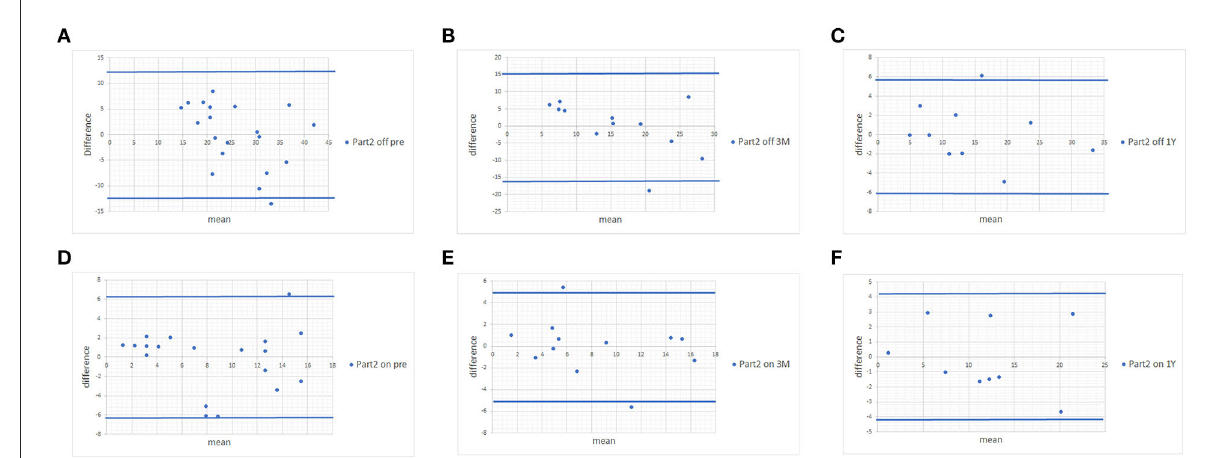
FIGURE1 Bland-Altman plots of MDS-UPDRS Part II scores and scores estimated from the UPDRS. (A) Pre-operative MDS-UPDRS during the off phase. (B) Post-operative MDS-UPDRS 3 months after surgery during the off phase. (C) Post-operative MDS-UPDRS 1 year after surgery during the off phase. (D) Pre-operative MDS-UPDRS during the on phase. (E) Post-operative MDS-UPDRS 3 months after surgery during the on phase. (F) Post-operative MDS-UPDRS 1 year after surgery during the on phase. The means of the two scores are displayed on the x-axis, and the difference between the score is displayed on the y-axis. The two blue lines represent the limits of agreement (average difference ± 1.96 standard deviation of the difference).